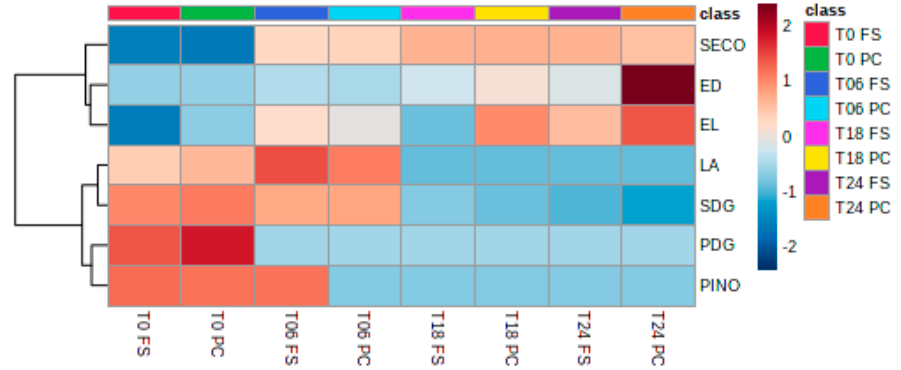
Figure 5. Heatmap of log-transformed concentrations of lignans and their degradation products (Euclidean distance measures and Ward’s clustering algorithm used). T0, T6, T18, T24 = observed timepoints 0 h, 6 h, 18 h, and 24 h; PC = digested flaxseed press cake, FS = digested milled whole flaxseed.